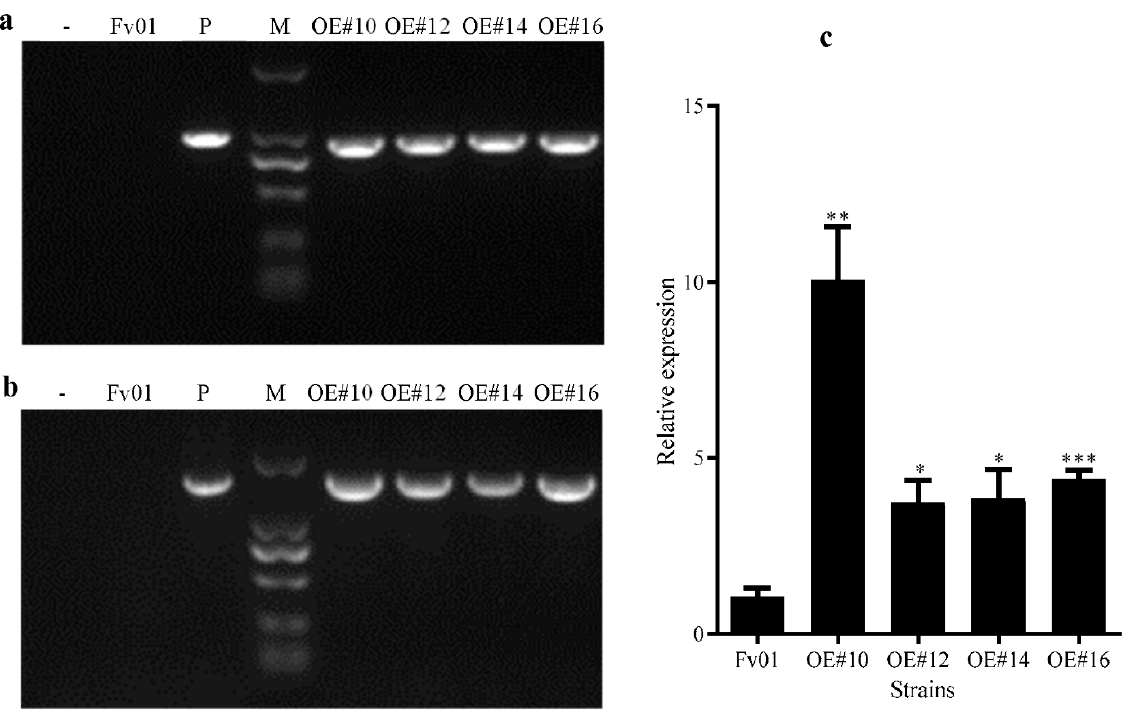
Figure 2. Verification of FfGS6 overexpression transformants of F. filiformis. ( a ) PCR verification of Hpt -resistant gene sequences of overexpression transformants. M, Maker DL2000; -, blank control with water as a template; Fv01, wild-type strain; P, positive control plasmid; OE#10, OE#12, OE#14, and OE#16, F. filiformis overexpression transformants. ( b ) PCR verification of the FfGS6 target gene sequence of the overexpression transformants. M, Maker DL2000; -, blank control with water as a template; Fv01, wild-type strain; P, positive control plasmid; OE#10, OE#12, OE#14, and OE#16, F. filiformis overexpression transformants. ( c ) qRT-PCR detection results of FfGS6 gene expression levels in different overexpression transformants. Asterisks represent significant differences versus Fv01 ( t -test, n = 3; *, p < 0.05; **, p < 0.01; ***, p < 0.001).